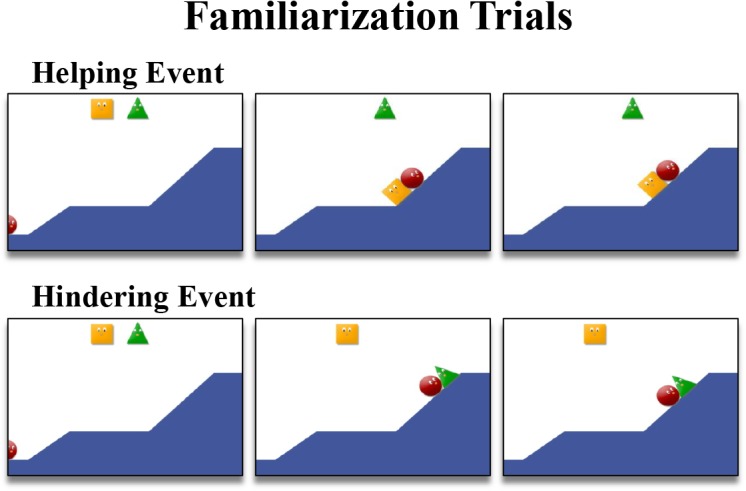
Example of the familiarization trials in Experiment 3.